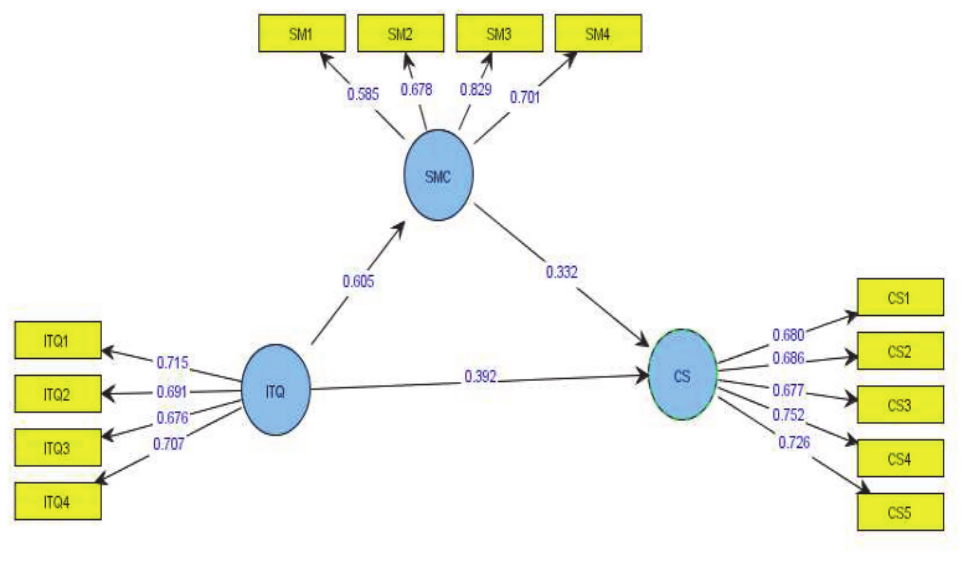
Fig. 1. Research Model and the Result